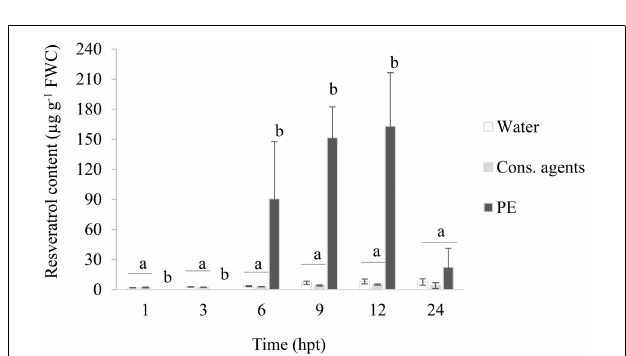
FIGURE 4 | Trans -resveratrol accumulation in the culture medium of PE-treated cells. Cell suspensions, adjusted to 0.1 g FWC mL − 1 , were treated with PE (0.5 g L − 1 ), or equal volumes of cons. agents or water. The culture medium was collected by vacuum filtration. Quantification of trans -resveratrol was performed by HPLC analysis and results correspond to the mean ± confidence interval of three independent biological repetitions. Significant differences ( p ≤ 0.05) were identified with Kruskal–Wallis coupled with Dunn’s multiple comparison test. Conditions with different letters are significantly different.